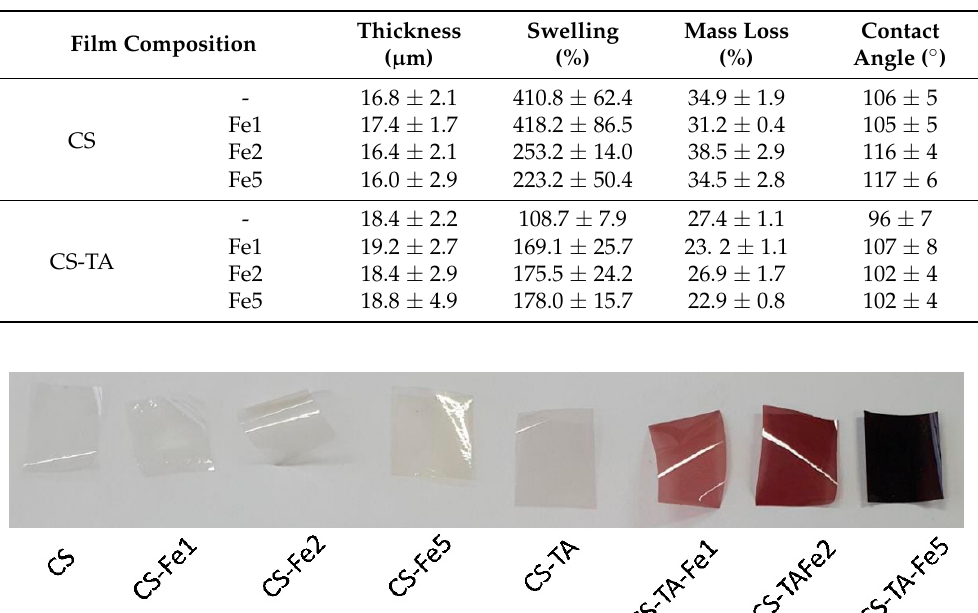
Table 2. Thickness, swelling, mass loss and contact angle of the films.